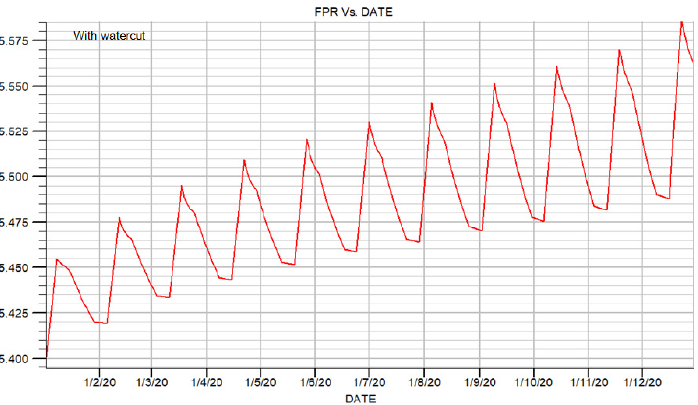
Figure 2. Field pressure (FPR) profiles of all three wells (X2, X6, and H1) with schedule 1wkInj- 1wkShut-2wkProd-1wkShut for one year.